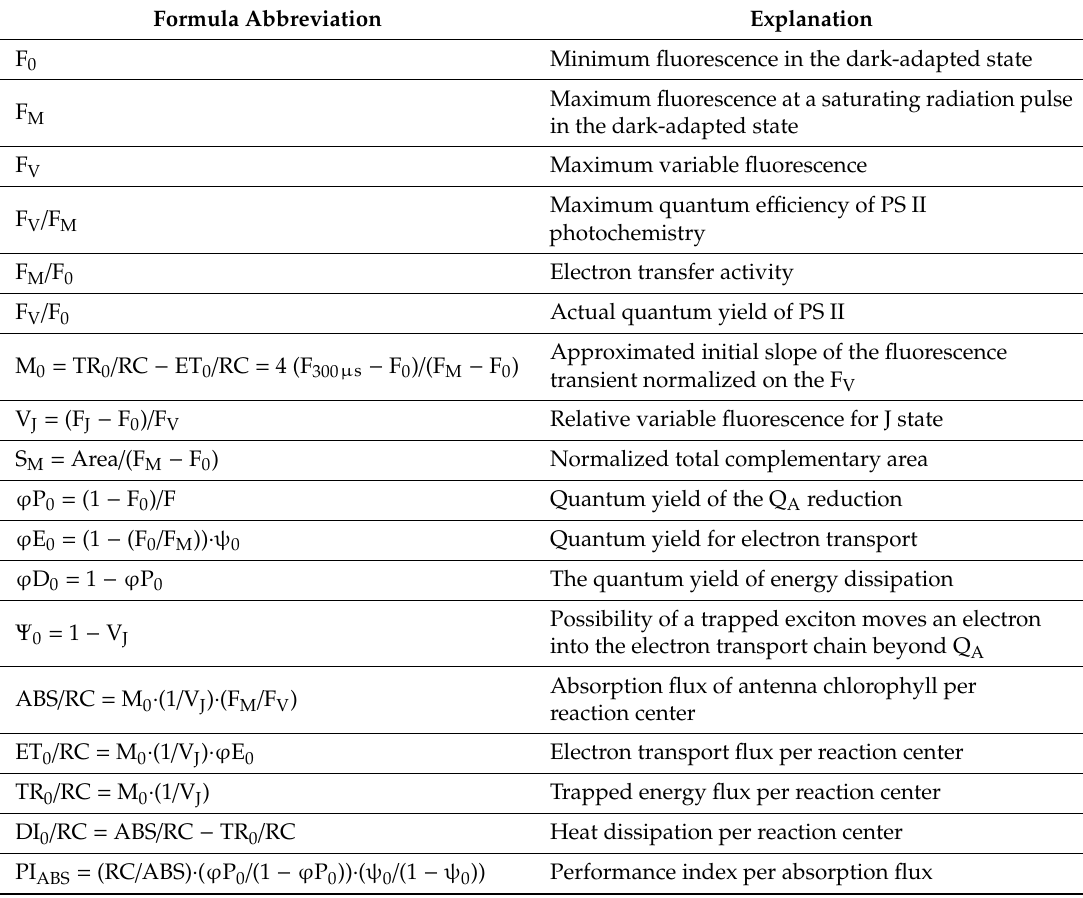
Table 1. Extracted and technical parameters deduced from chlorophyll a fluorescence induction curve